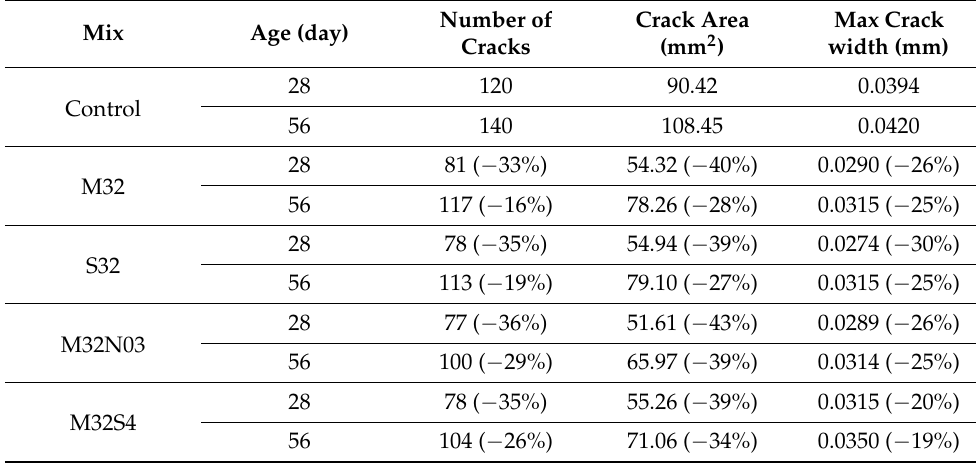
Table 7. Summary of the cracking performance.